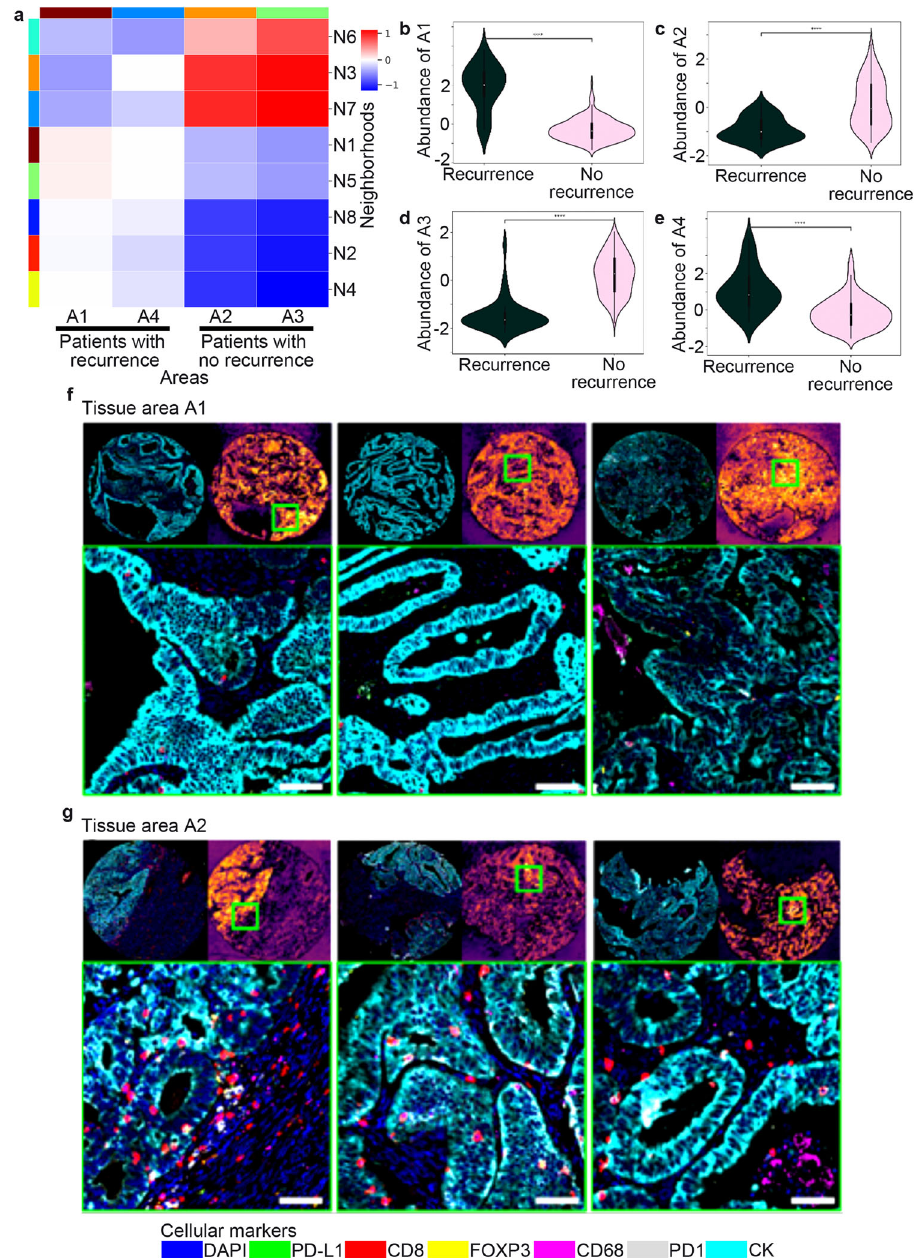
Fig. 5 Interpretability of tissue areas. a Heatmap showing four conserved, distinct tissue areas (A1 – 4) composed of the spatially interacting cellular neighborhoods (N1 – 8). For visualization, relative abundances of cellular neighborhoods were normalized by columns; the maximum value for each cellular neighborhood in a tissue area is one. b , e Relative abundances of tissue areas A1 and A4 associated with tumors with recurrence are shown. c , d Relative abundances of tissue areas A2 and A3 associated with tumors with no recurrence are shown. f Top-3 tumor core images assigned to tissue area A1, which is associated with tumors with recurrence. For each one of the representative panel of images: the top left image shows the whole tumor core, the top right image shows the image patch con fi dence when assigning to tissue area, the bottom image shows a tumor region with the highest relevant information from tissue area A1 (more associated with tumors with recurrence). Tissue area A1 shows very little immune cell in fi ltration, representing “ nonin fl amed ” or “ cold tumors ” . g Top-3 tumor core images assigned to tissue area A2, which is associated with tumors with no recurrence. For each one of the representative panel of images: the top left image shows the whole tumor core, the top right image shows the image patch con fi dence when assigning to the tissue area, the bottom image shows a tumor region with the highest relevant information from tissue area A2 (more associated with tumors with no recurrence). Tissue area A2 is one of the most immune in fi ltrated, representing “ in fl amed ” or “ hot tumors ” . Data were analyzed using a two-sided Mann – Whitney – Wilcoxon test with Bonferroni correction. ****, P values: A1 = 2.22e-29, A2 = 5.93-16, A3 = 6.25e-31, and A4 = 2.04e-12. Scale bars, 100 μ